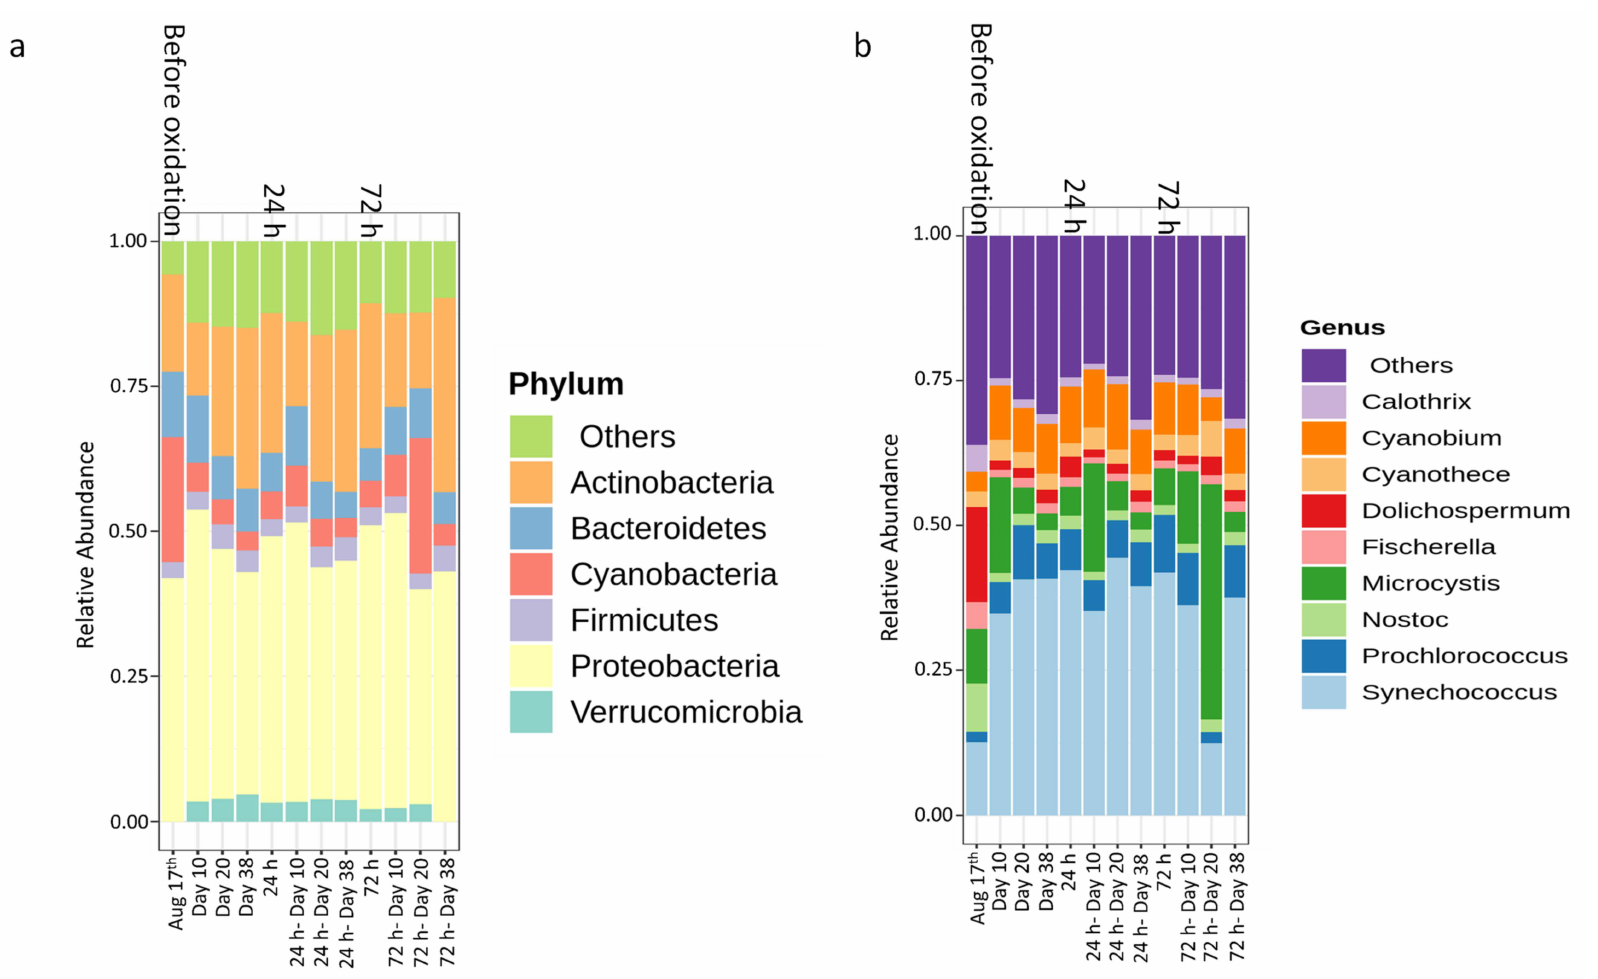
Figure 8. Taxonomic composition before/after on-site oxidation by 10 mg/L KMnO4 and stagnation on 17 August: ( a ) Microbial communities at the phylum level, ( b ) Cyanobacterial communities at the genus level. 24 h and 72 h: Oxidation contact time, Day: Stagnation